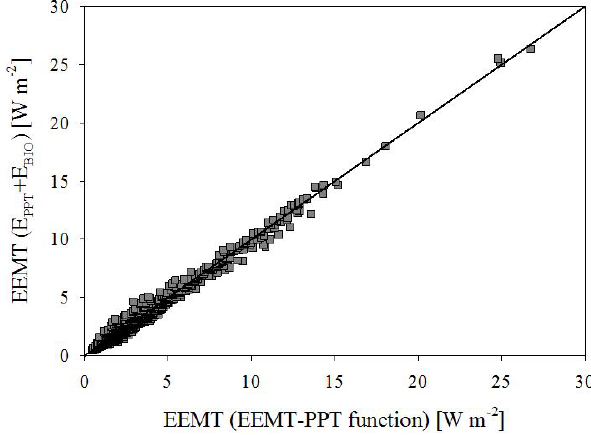
Fig. 4. Relationship of effective energy and mass transfer (EEMT) derived from empirical estimates of energy associated with primary production ( E BIO ) and effective precipitation ( E PPT ) relative to EEMT predicted with temperature dependent EEMT-PPT function. Solid line is the 1:1 line. A close fit between these data is expected, but demonstrates that the EEMT-PPT function effectively describes the E BIO + E PPT .